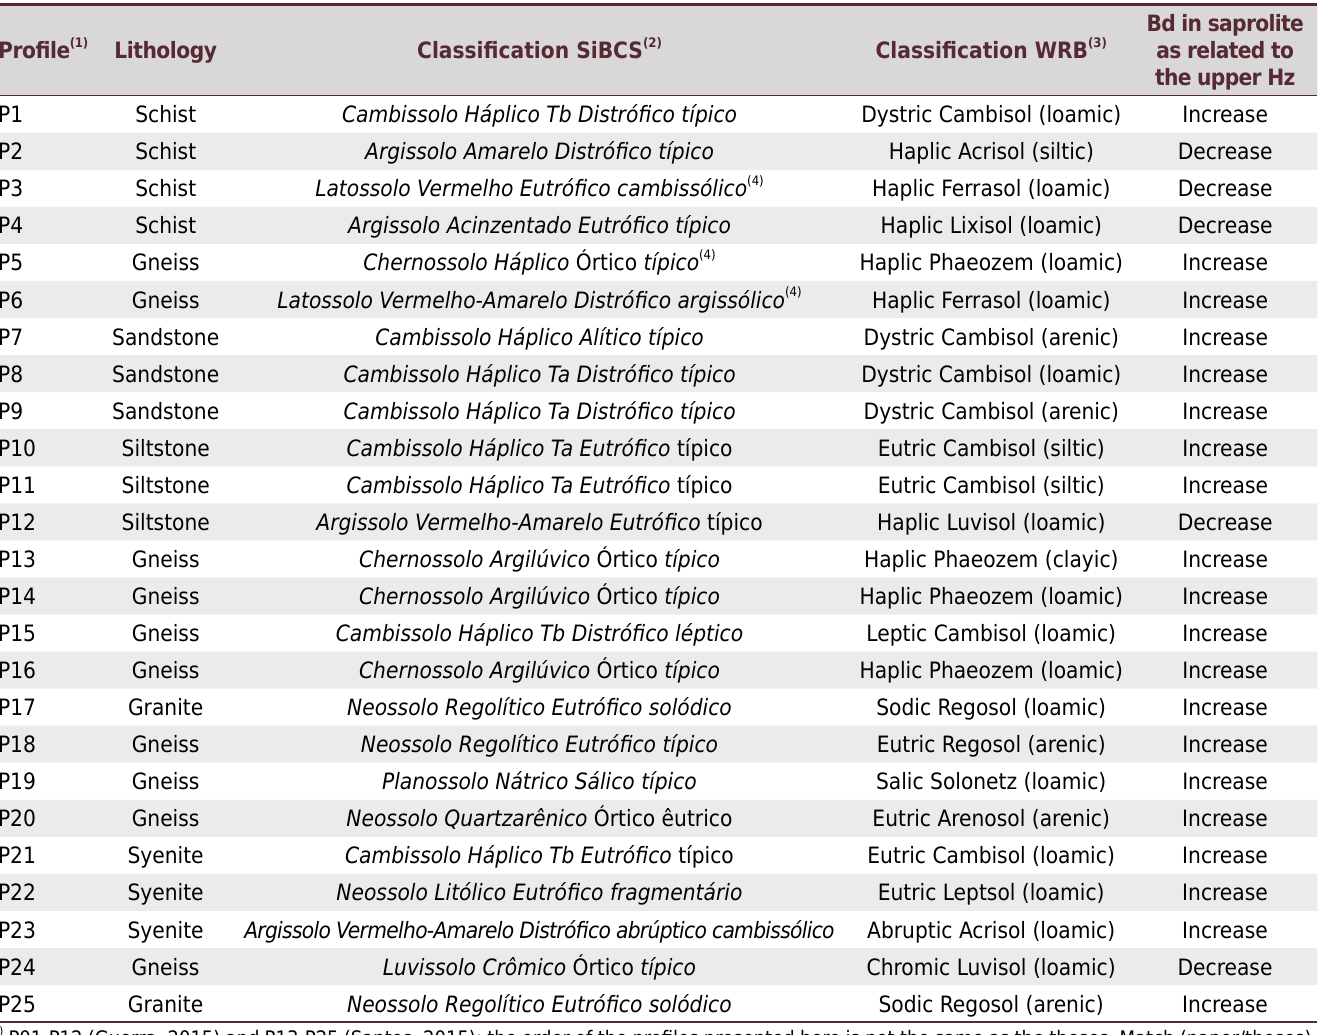
Table 1. Regolith profiles used in the decision tree algorithm Profile